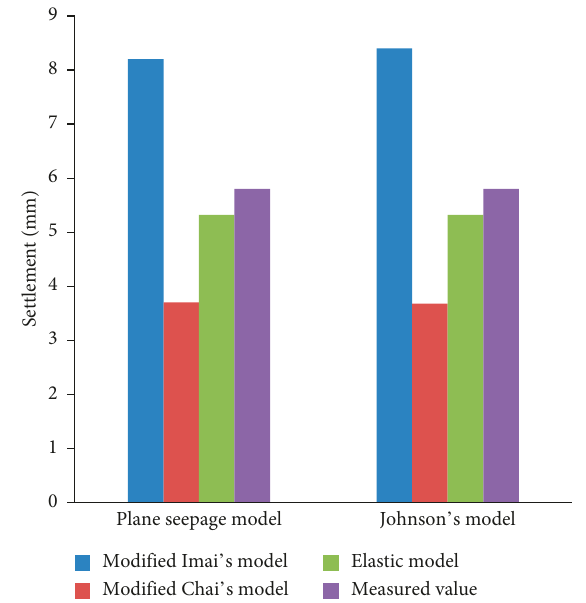
Figure 5: Results of theoretical